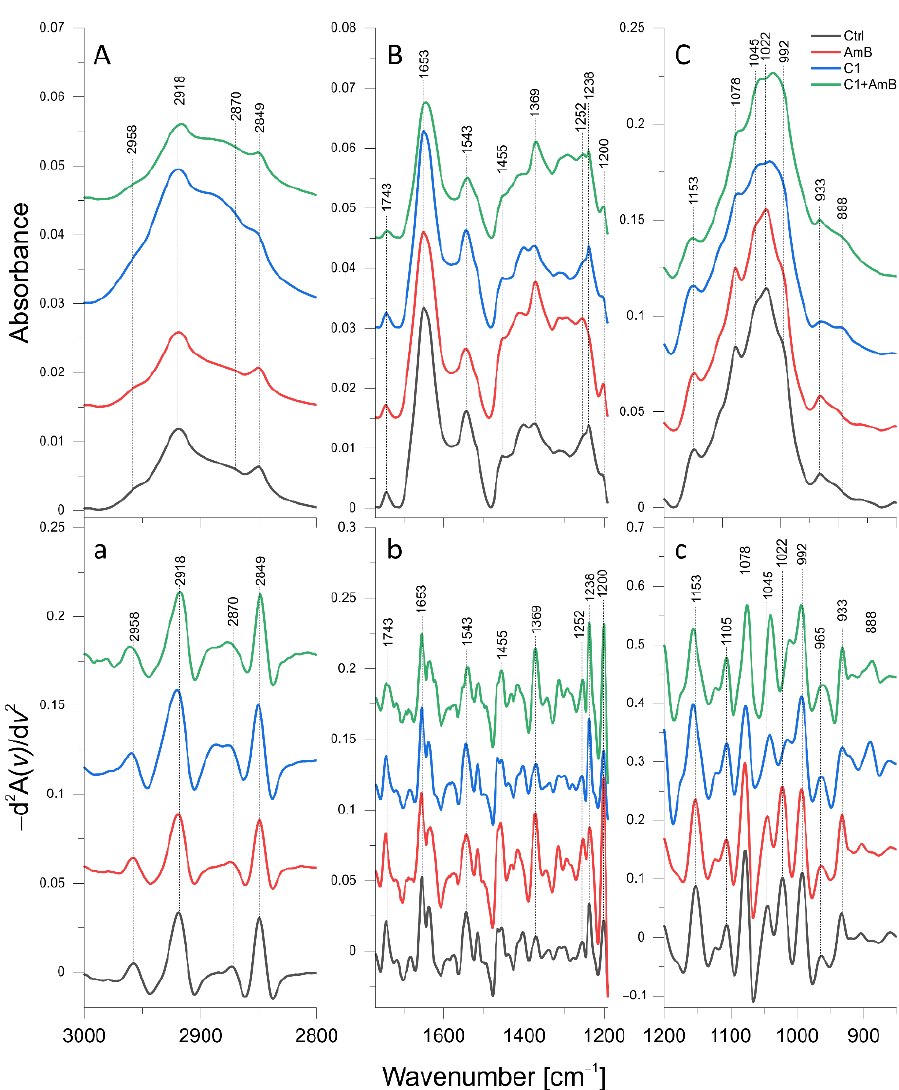
Figure 5. Mean ATR-FTIR spectra for the control C. albicans cells and cells treated with AmB (0.03 µ g/mL), C1 (8 µ g/mL), and their combination, respectively: ( A )—3000–2800 cm − 1 region of ATR-FTIR spectra; ( B )—1750–1190 cm − 1 region of ATR-FTIR spectra; ( C )—1200–800 cm − 1 region of ATR- FTIR spectra; ( a – c )—reversed second derivatives of spectra presented in ( A – C